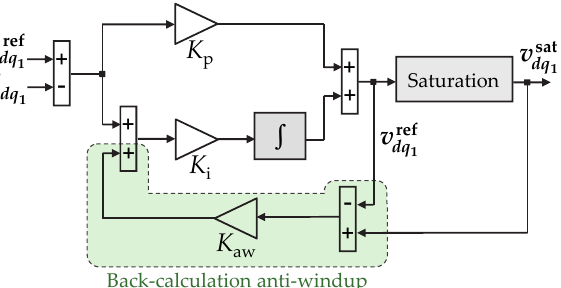
Figure 30. Anti-wind-up based on back-calculation for synchronous PI current control with output voltage saturation in α 1 - β 1 plane, as for n = 3